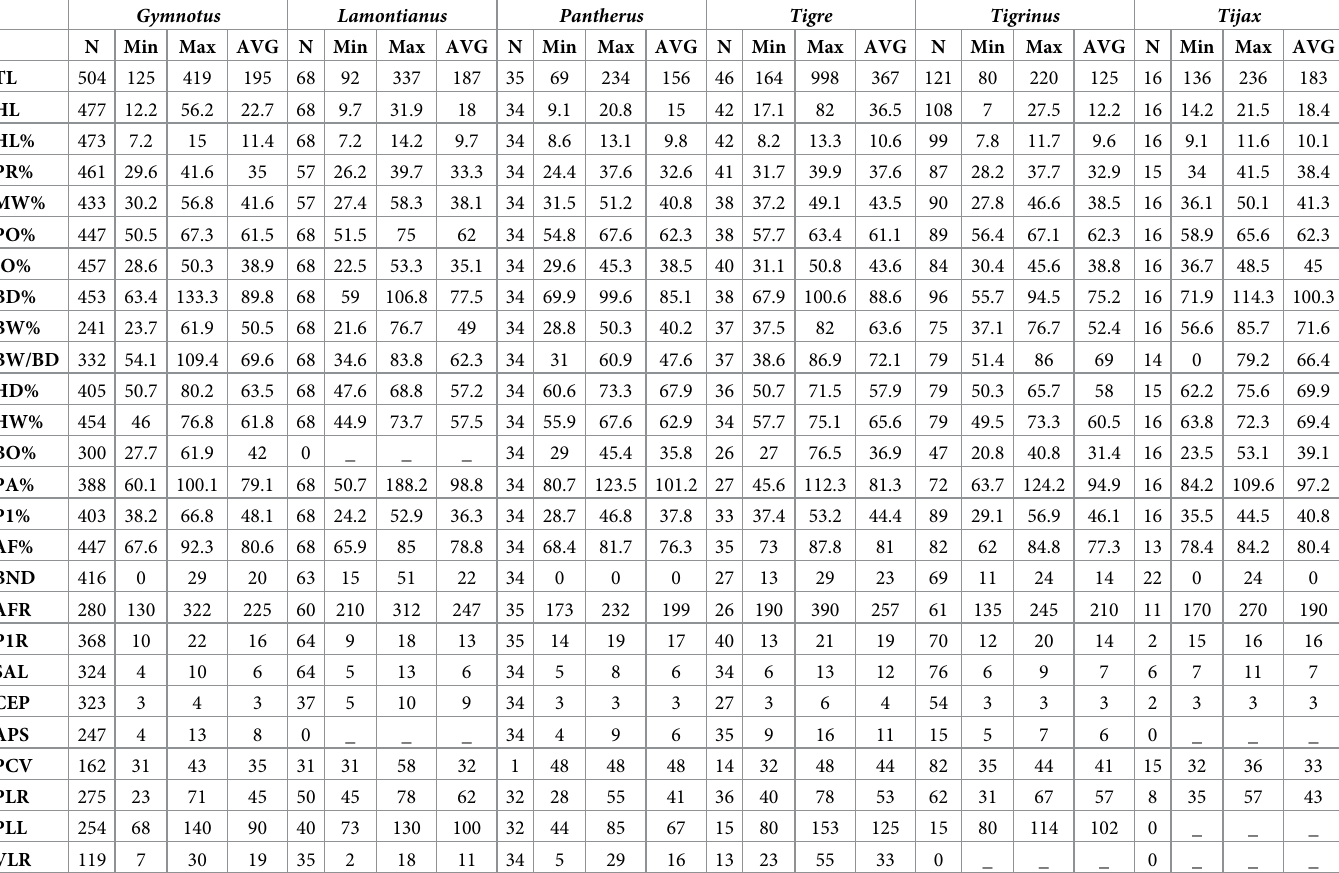
Table 5. Summary of morphometric and meristic data for the six gymnotine subgenera recognized herein. Data for 796